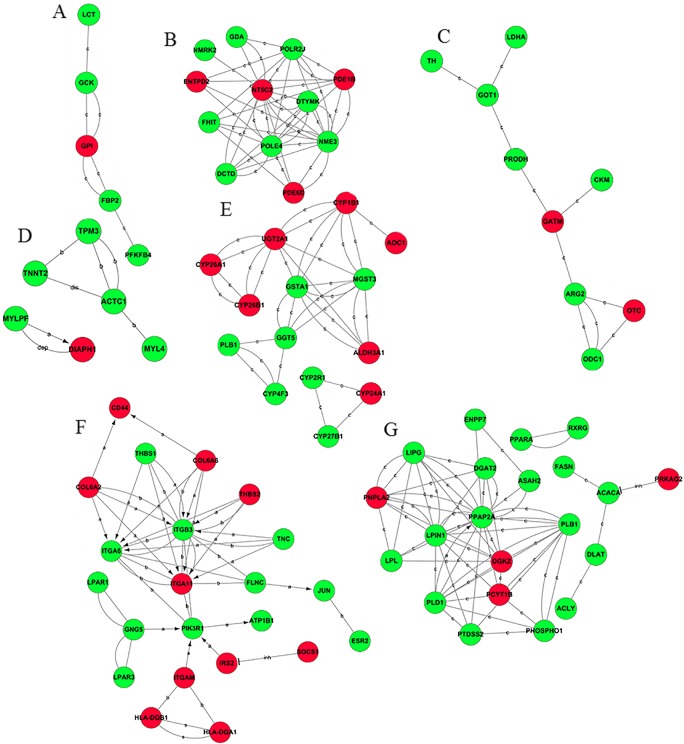
Gene act subnetworks in the 0 vs 8 psu categories.(A): glucose utilization; (B): nucleotide metabolism; (C): protein and amino acid metabolism; (D): cytoskeleton; (E): oxidative stress; (F): PI3K signaling pathways; (G): lipid and glycerophospholipid metabolism. The red ball represents the up-regulated genes, while the green ball represents the down-regulated genes. The connections of genes were generated from the data analysis consisting of GO analysis and KEGG pathway. The solid lines represent the relationships between genes. The dashed lines represent the genes that have an indirect effect. The arrow represents activation. The flathead represents suppression. ‘a’ represents activation; ‘b’ represents binding; and ‘c’ represents compound. The abbreviation ‘dep’ represents phosphorylation; ‘dis’ represents dissociation; and ‘inh’ represents inhibition.